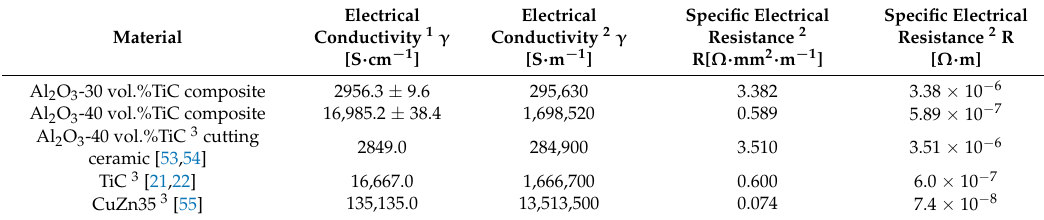
Table 2. Electrical properties of Al 2 O 3 -TiC composites with 30 and 40 vol.% TiC.